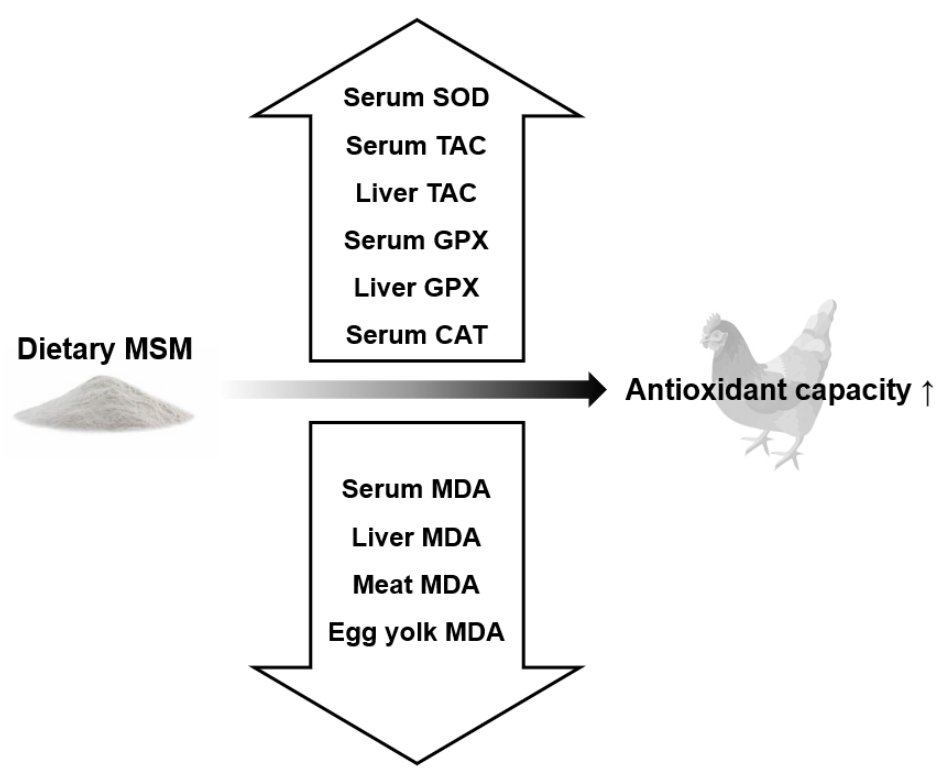
Figure 3. Effects of dietary methyl sulfonyl methane on the biomarkers of oxidative stress in poultry. SOD: superoxide dismutase; TAC: total anti-oxidant capacity; GPX: glutathione peroxidase; CAT: catalase; MDA: malondialdehyde.